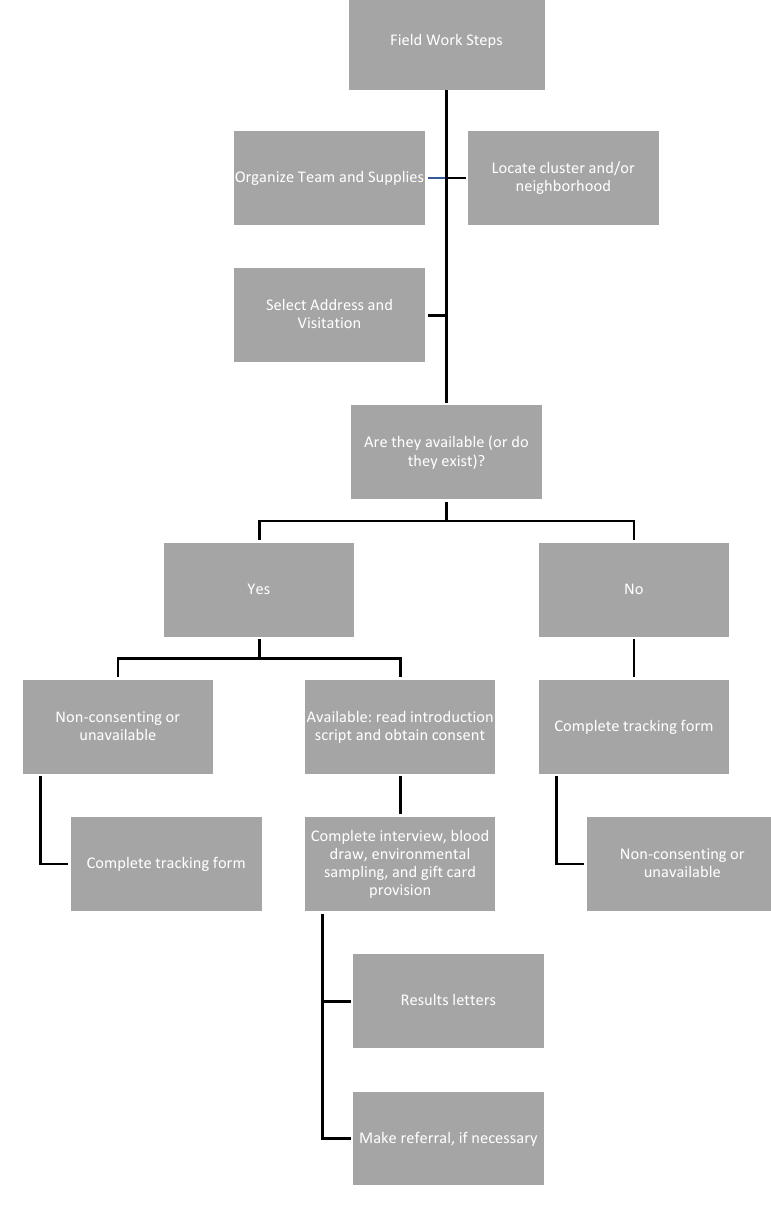
Figure 2. Flow chart of field work steps.